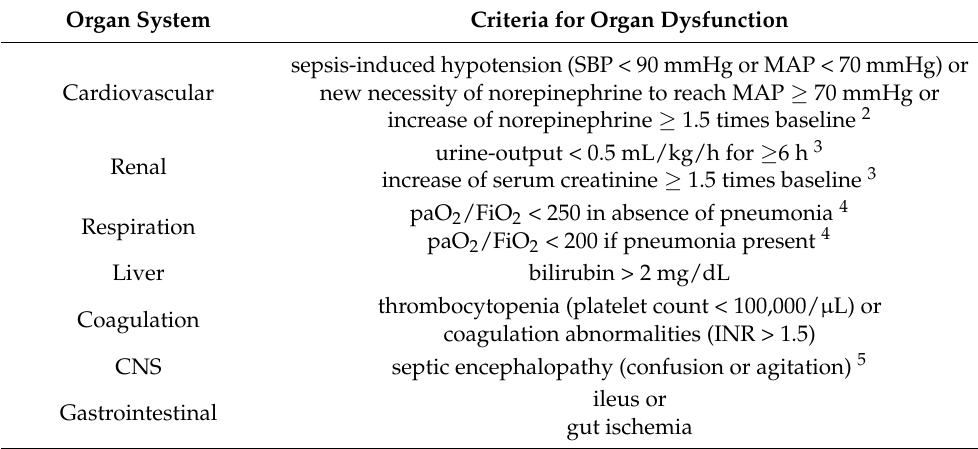
Table 1. Alternative sepsis criteria to detect an organ dysfunction caused by a dysregulated host response to infection 1 .